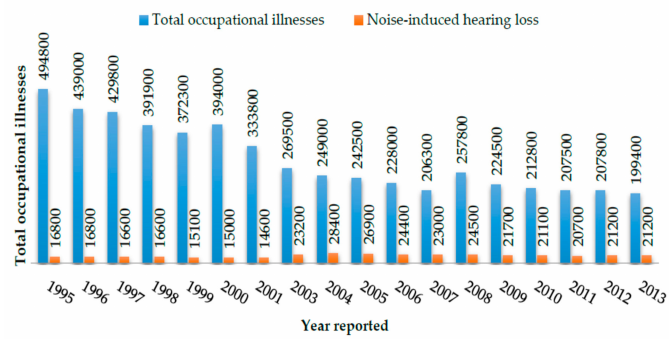
Figure 1. Occupational illnesses reported in the United States.